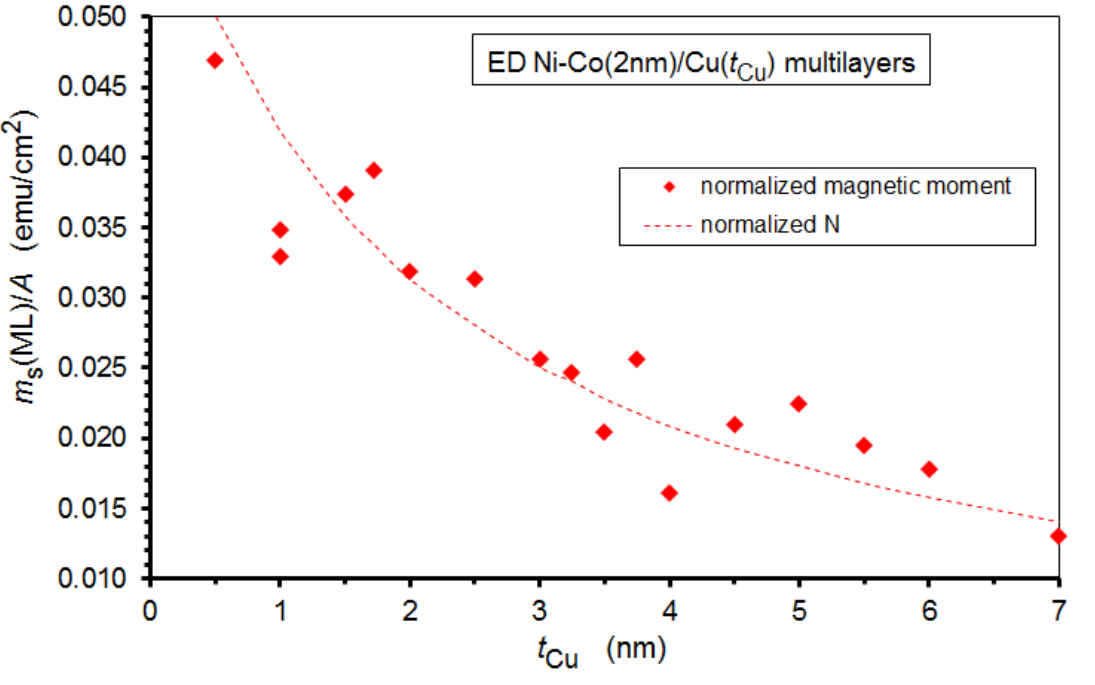
Figure 11. Measured saturation magnetic moment per unit surface area m s(ML)/ A (diamond symbols) for the present Ni65Co35/Cu multilayers with various non-magnetic layer thicknesses ( t Cu ). The dashed line represents the appropriately normalized bilayer number to demonstrate that the measured magnetic moment is reduced just in the same manner as the decrease of the number of magnetic layers in the multilayer stack.